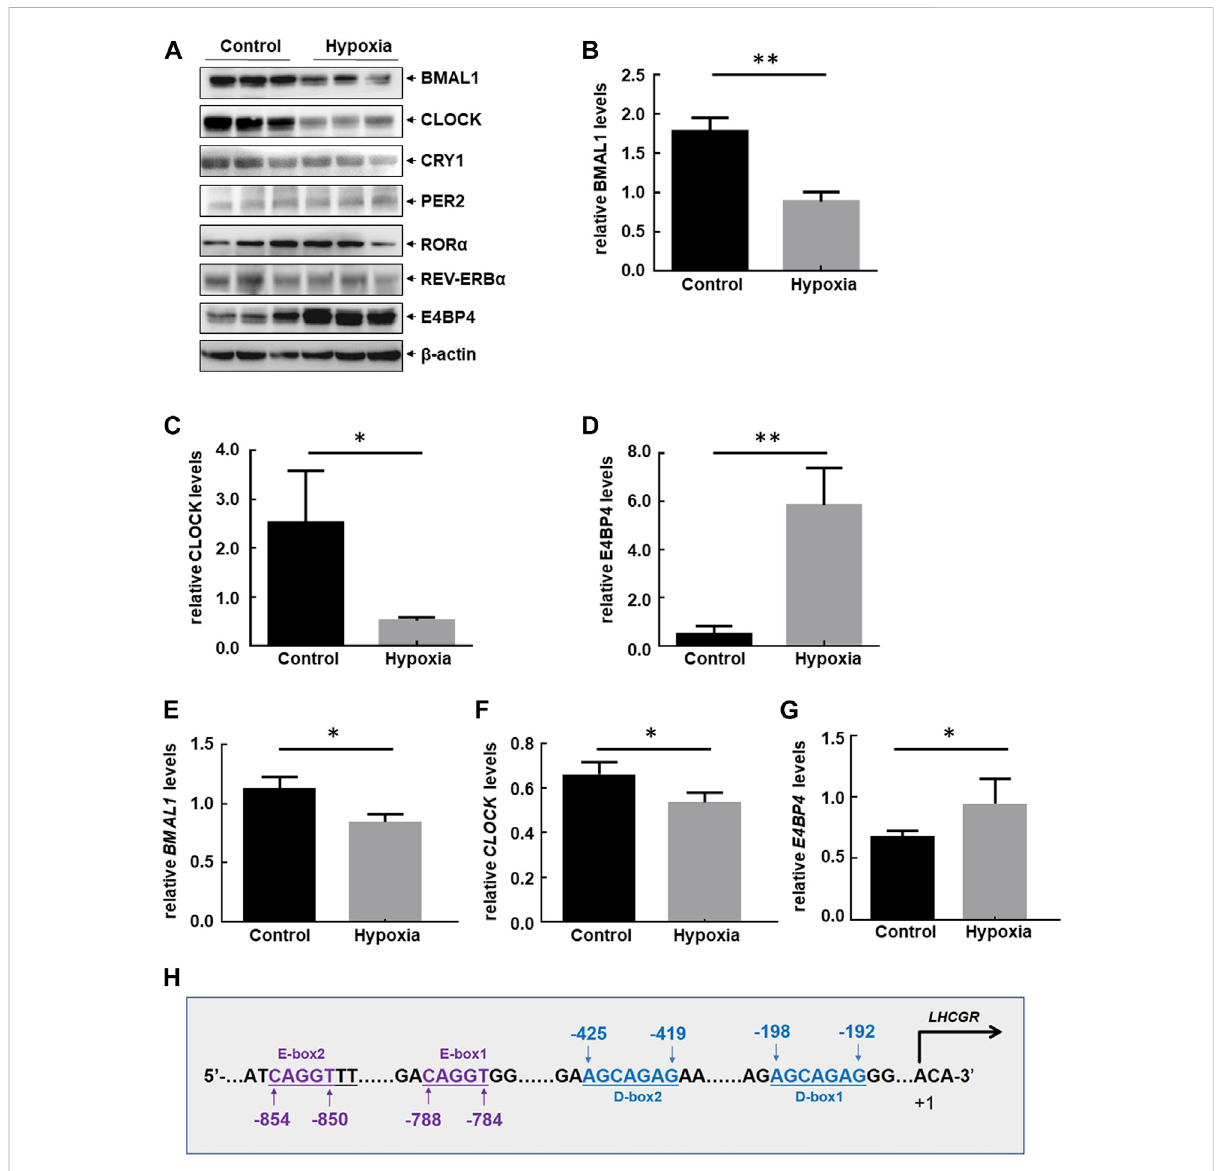
FIGURE 3 Hypobaric hypoxia-induced disorder of circadian clock protein expression in the ovaries of female mice. (A – D) Female mice were treated as shown in Figure 1A. Ovaries were collected 48 h after hypoxic exposure, and the expression levels of circadian clock proteins were detected. The WesternblotquantitativeresultsofCLOCK,BMAL1,andE4BP4(relativeto β -actin)areshown (B – D) ( n =6,** p < 0.01;* p < 0.05).TheRT-PCRresults of BMAL1, CLOCK, and E4BP4 (relative to β -actin ) are shown (E – G) ( n = 3, * p < 0.05). (H) Potential CLOCK:BMAL1- and E4BP4-binding sites (E-box and D-box) were identi fi ed within mouse LHCGR promoter